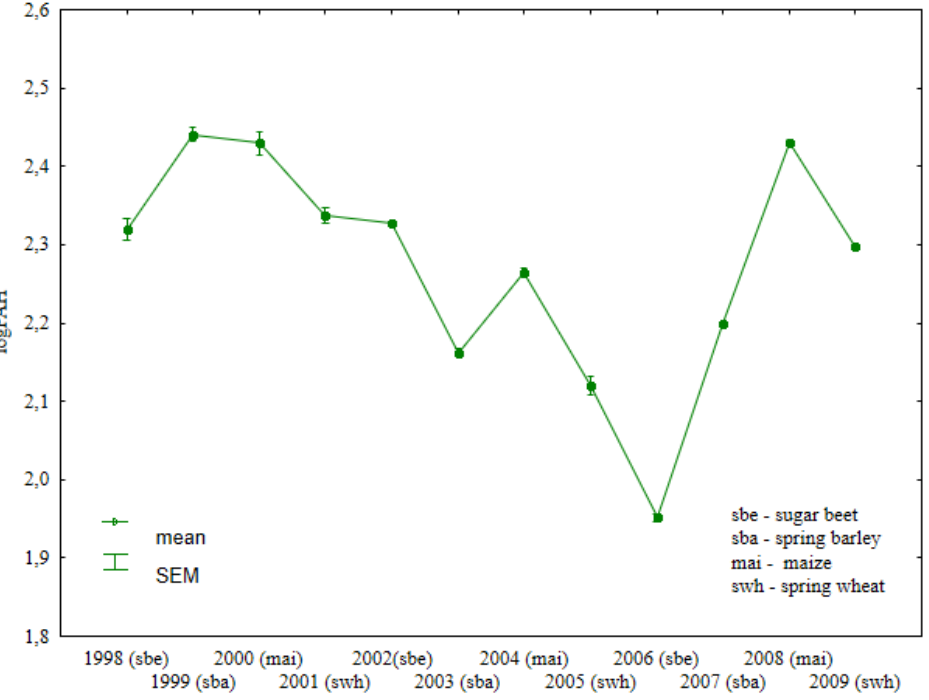
Figure 5. Total content of 16 PAHs in soil under different crops (log transformed data for 1998– 2009).